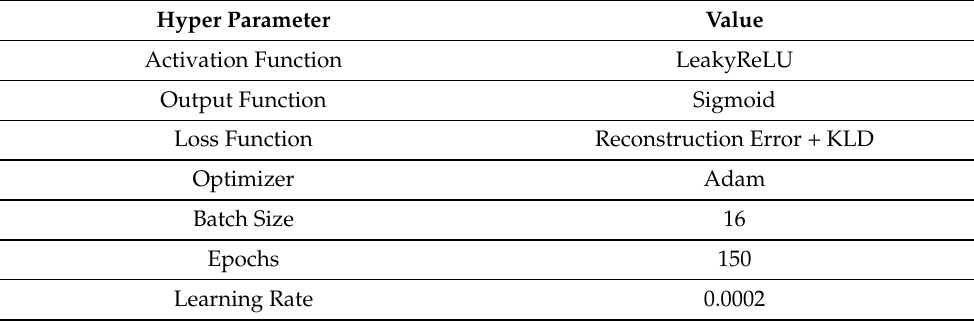
Table 2. Hyperparameter setting of the VAE model.